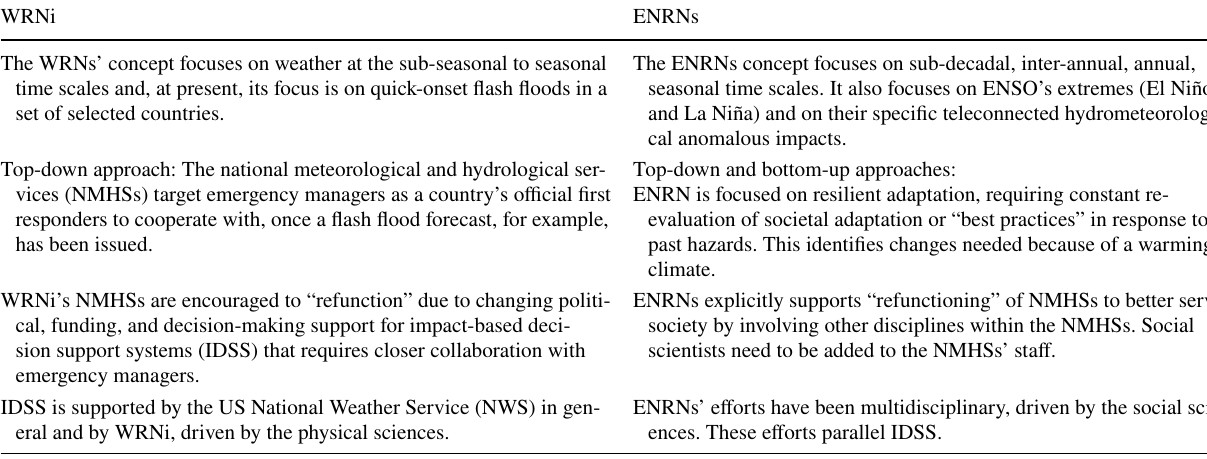
Table 1 Suggested general differences between International Weather-Ready Nation (WRNi) and El Niño Ready Nations (ENRN) with poten- tial for complementary activities WRNi ENRNs The WRNs’ concept focuses on weather at the sub-seasonal to seasonal time scales and, at present, its focus is on quick-onset flash floods in a set of selected